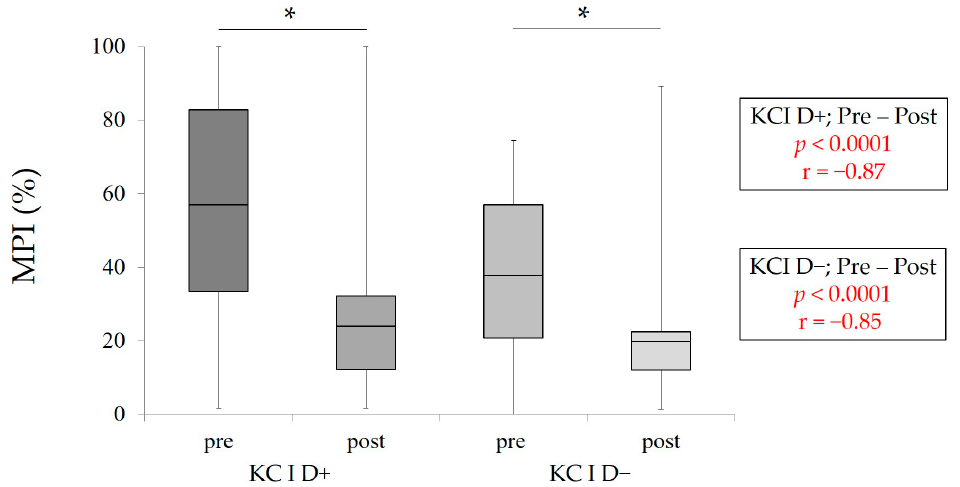
Figure 3. Pre- and post-MPI in in KC I D+ and D − . The statistical analyses were conducted between pre- and post-values in KC I D+ and D − , respectively * p < 0.05, Wilcoxon signed-rank test, r: effect size.